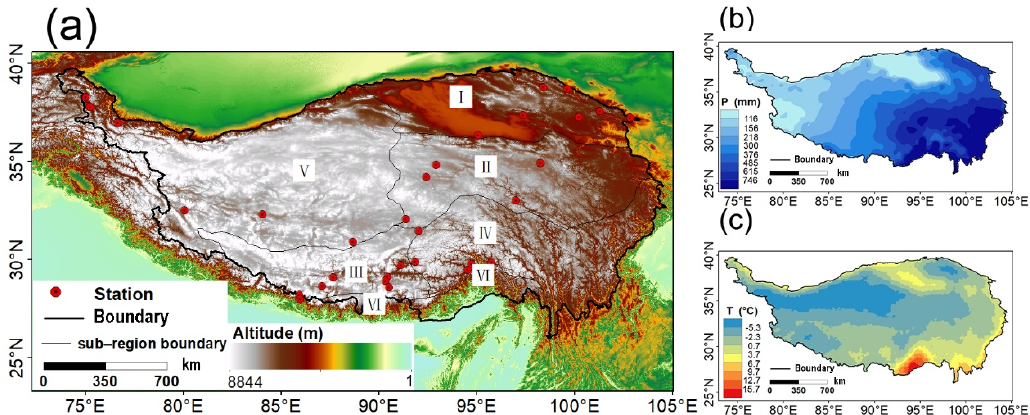
Figure 1. Maps showing sampling sites and altitude ( a ), long-term annual mean precipitation amount ( b ), and air temperature ( c ) in the Qinghai-Tibet Plateau (QTP).